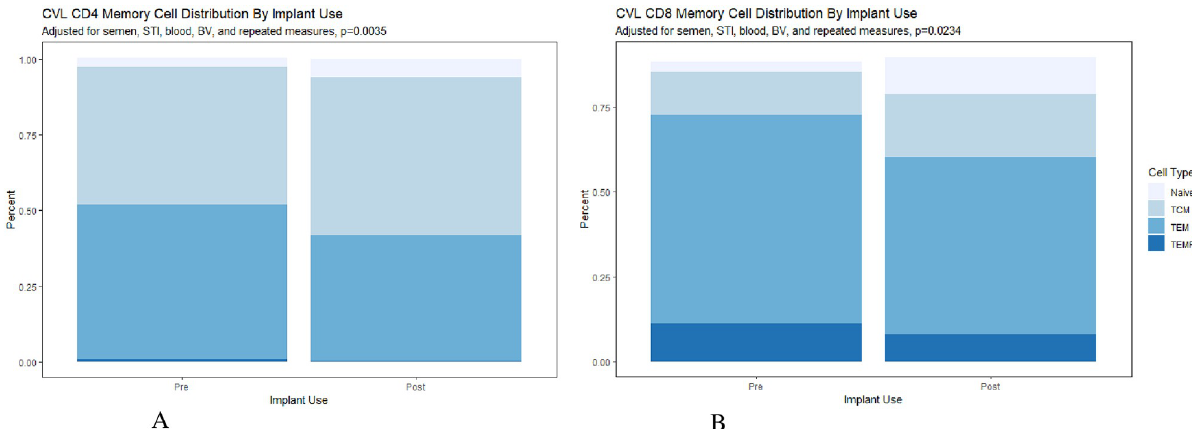
Fig 1. a. CVL CD4 memory cell distribution before and after implant use, adjusting for time-varying semen presence by PSA, sexually transmitted infections, bacterial vaginosis, presence of blood in the sample and repeated measures, p = 0.004. b. CVL CD8 memory cell distribution before and after implant use, adjusting for time-varying semen presence by PSA, sexually transmitted infections, bacterial vaginosis, presence of blood in the sample and repeated measures p = 0.023. Memory cell phenotypes included Na ï ve T-cell (CD45RA hi and CCR7 hi ); Tcm = central memory T-cells (CD45RA lo and CCR7 hi ; Tem = effector memory T-cells (CD45RA lo and CCR7 lo ) and T EMRA = effector memory RA expressing T-cells (CD45RA hi and CCR7 lo ).